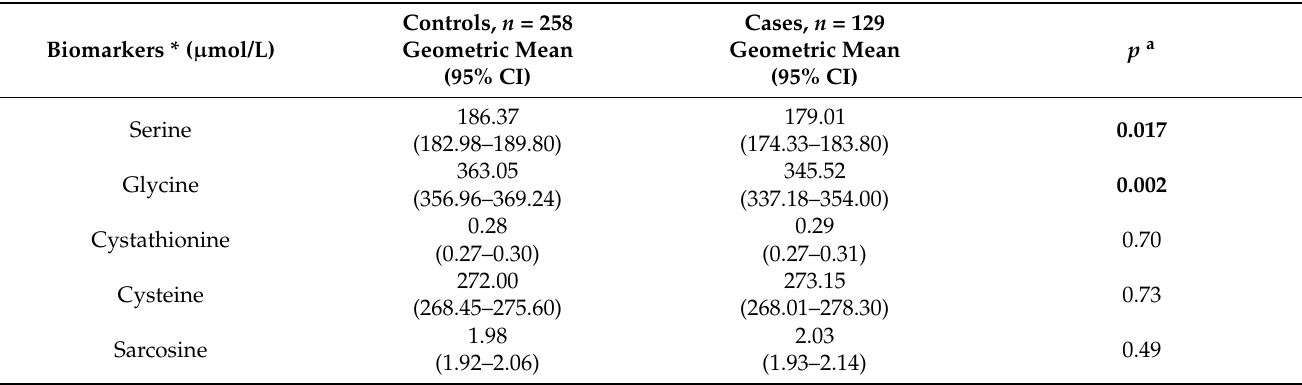
Table 2. Geometric means of serum concentrations of biomarkers studied in pancreatic cancer cases and control subjects in the Shanghai Cohort